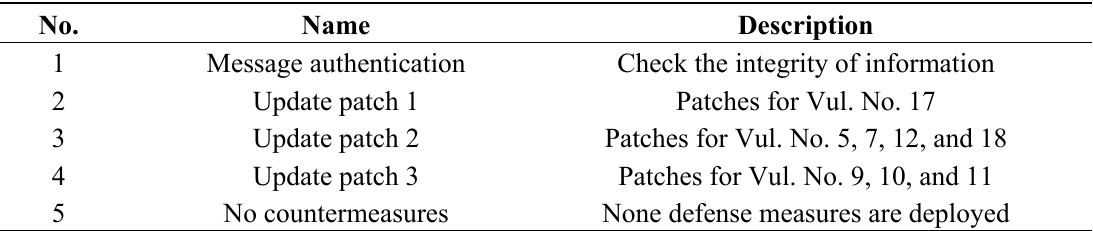
Table 5. Description of defense strategies.